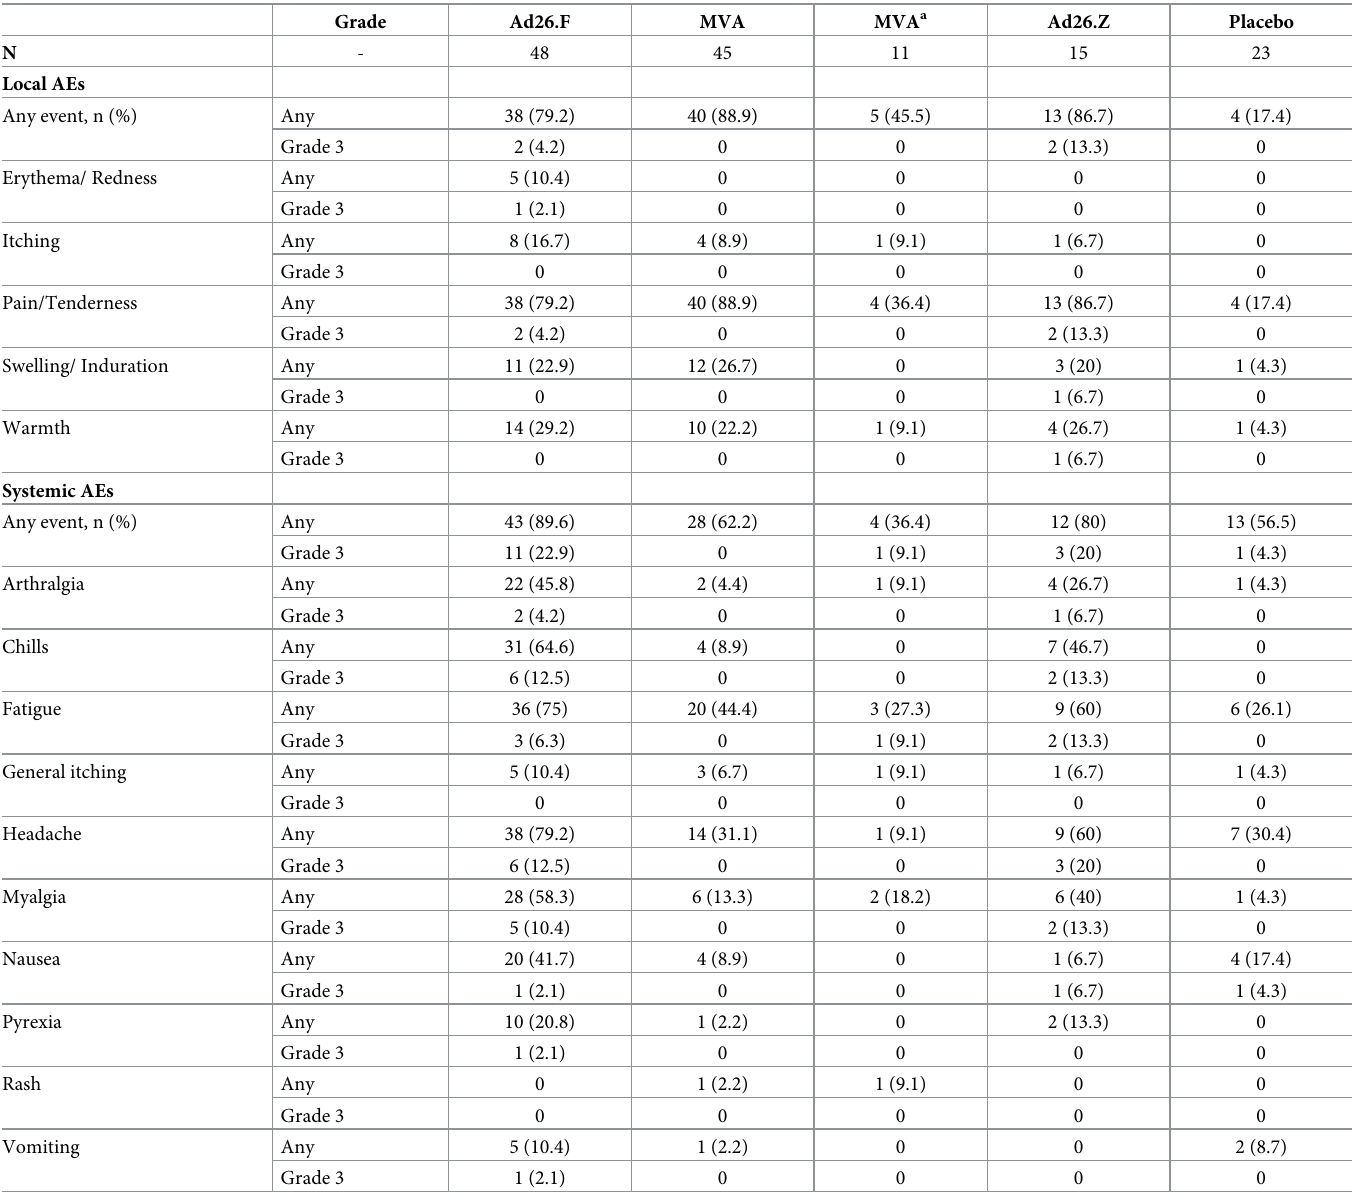
Table 2. Solicited local and systemic AEs by worst severity grade by dose; full analysis